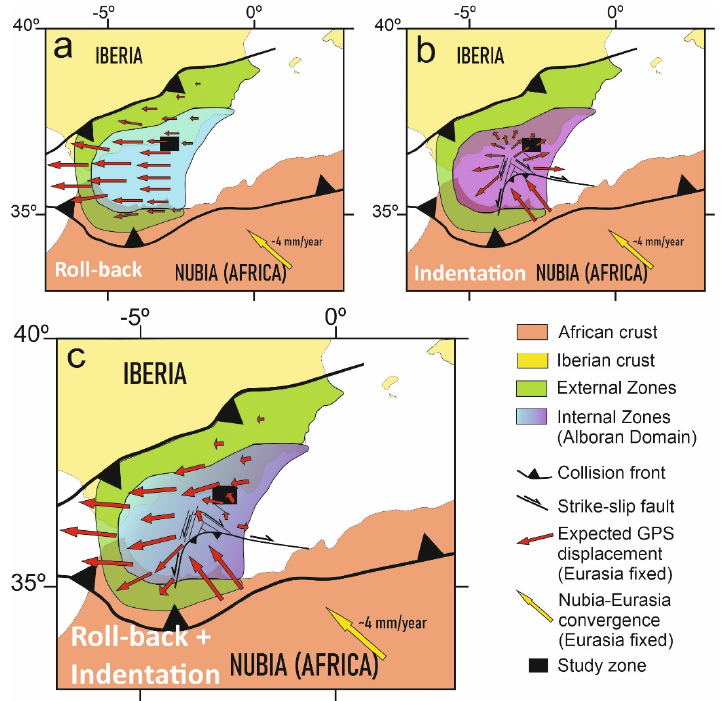
Figure 7. Expected displacement patterns during the development of the Gibraltar Arc with respect to stable Eurasia by ( a ) roll-back tectonics, with a regional westward displacement increasing to- ward the central and western parts of the tectonic arc; ( b ) indentation tectonics, with a radial pat- tern; and ( c ) the interaction of roll-back and indentation tectonics—in agreement with the Campo de Dalias GNSS network’s present results, the residual velocity field decreases and rotates clock- wise from the north towards the south of the study area. 7. Conclusions Despite the long periods necessary to yield suitable results in regions with slow deformation, GNSS network observations provide independent data that improve our geological and geophysical understanding of active tectonic structures. The GNSS Campo de Dalias network shows that the entire region is affected by continuous defor- mation, including north-northwest–south-southeast convergence accommodated by east-northeast–west-southwest folds, and orthogonal east-northeast–west-southwest ex- tension accommodated by normal faults. The GNSS results highlight the activity of the north-northwest–south-southeast normal Balanegra Fault, which constitutes a complex structure of 10 km in length, south of the Gádor Range, with a shallow dextral creep displacement of up to 1 mm/year, and a deep seismic character. At a regional scale, the study area accommodated deformation of the north-northeast tip of the sinistral Betic–Alboran shear zone, crossing the Alboran Sea. The pattern of active deformation, with westward displacement decreasing toward the south, is consistent with the coexistence in this region of roll-back tectonics—a driving process well developed in the western Gibraltar Arc—and indentation tectonics, domi- nant farther east and south. These results point to the coexistence of different tectonic mechanisms during the development in the westernmost Mediterranean, leading to the development of the Gibraltar Arc.